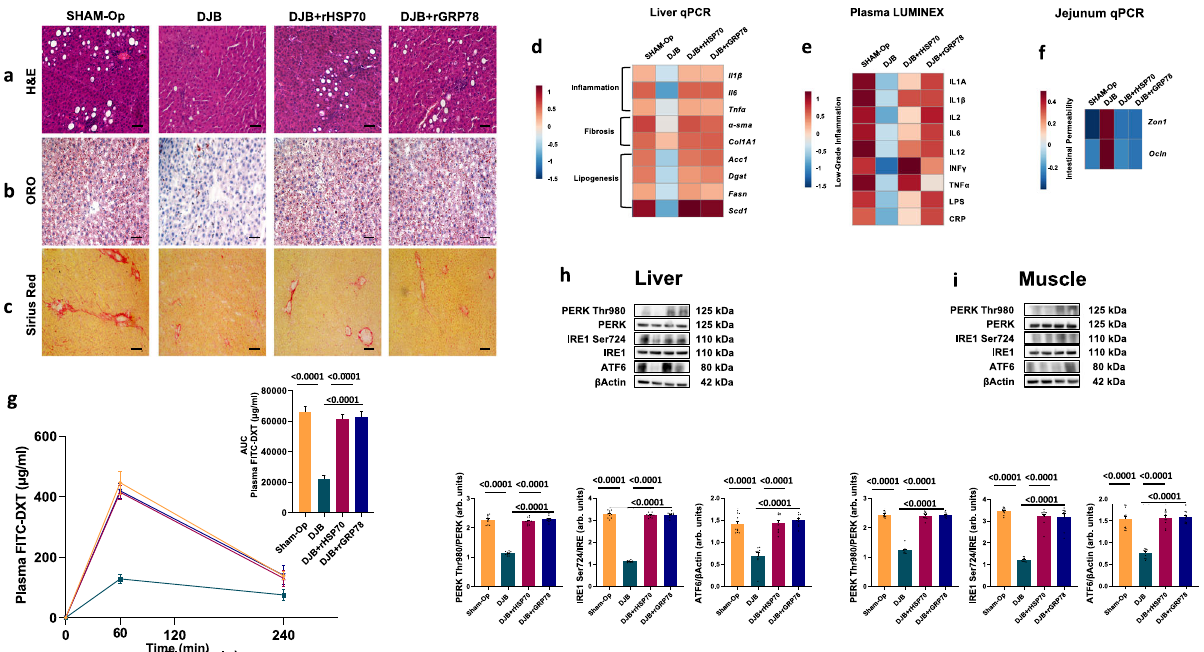
Fig. 7 | Effects of the infusion of HSP70 and GRP78 in Duodenal-Jejunal Bypass (DJB) on NASH hallmarks. a – c Representative Hematoxylin and Eosin (H&E) ( a ), OilRedO(ORO)( b ),and PicroSirius Red( c )stainingofliversectionsfromratsfed HFD that underwent Sham-operation (Sham-op) or DJB and infused with recom- binant HSP70 or GRP78 or saline solution. d Gene expressionofliverin fl ammation and fi brosis markers as well as key enzymes involved in hepatic de novo lipogen- esis. e Plasma low-grade in fl ammation markers assessed by Luminex. f Gene